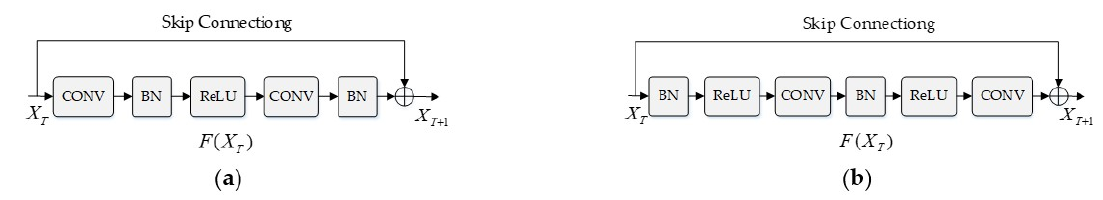
Figure 6. Residual block ( a ) Original structure; ( b ) Improved